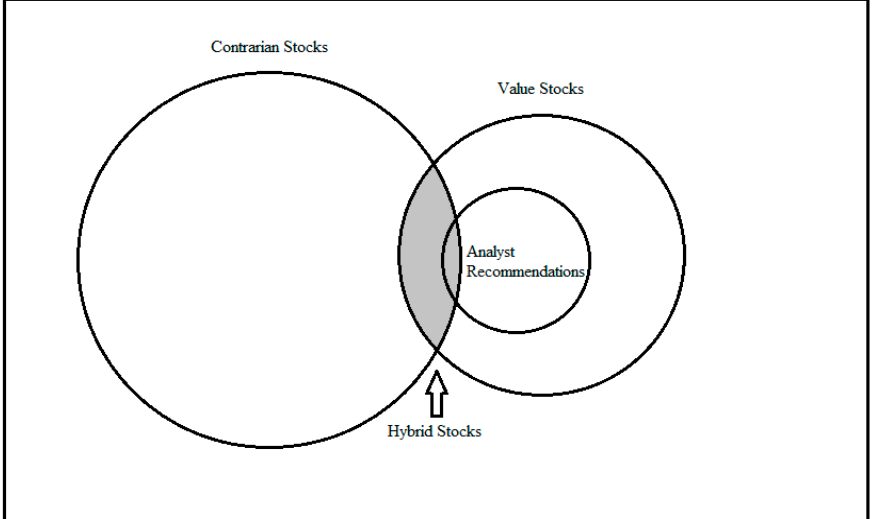
Figure 3. Venn Figure 3. Venn diagram.